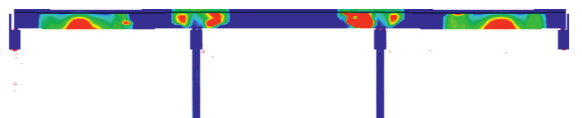
Figure 26: Principal normal strain at the end of the analysis, “model A3-C-C.”